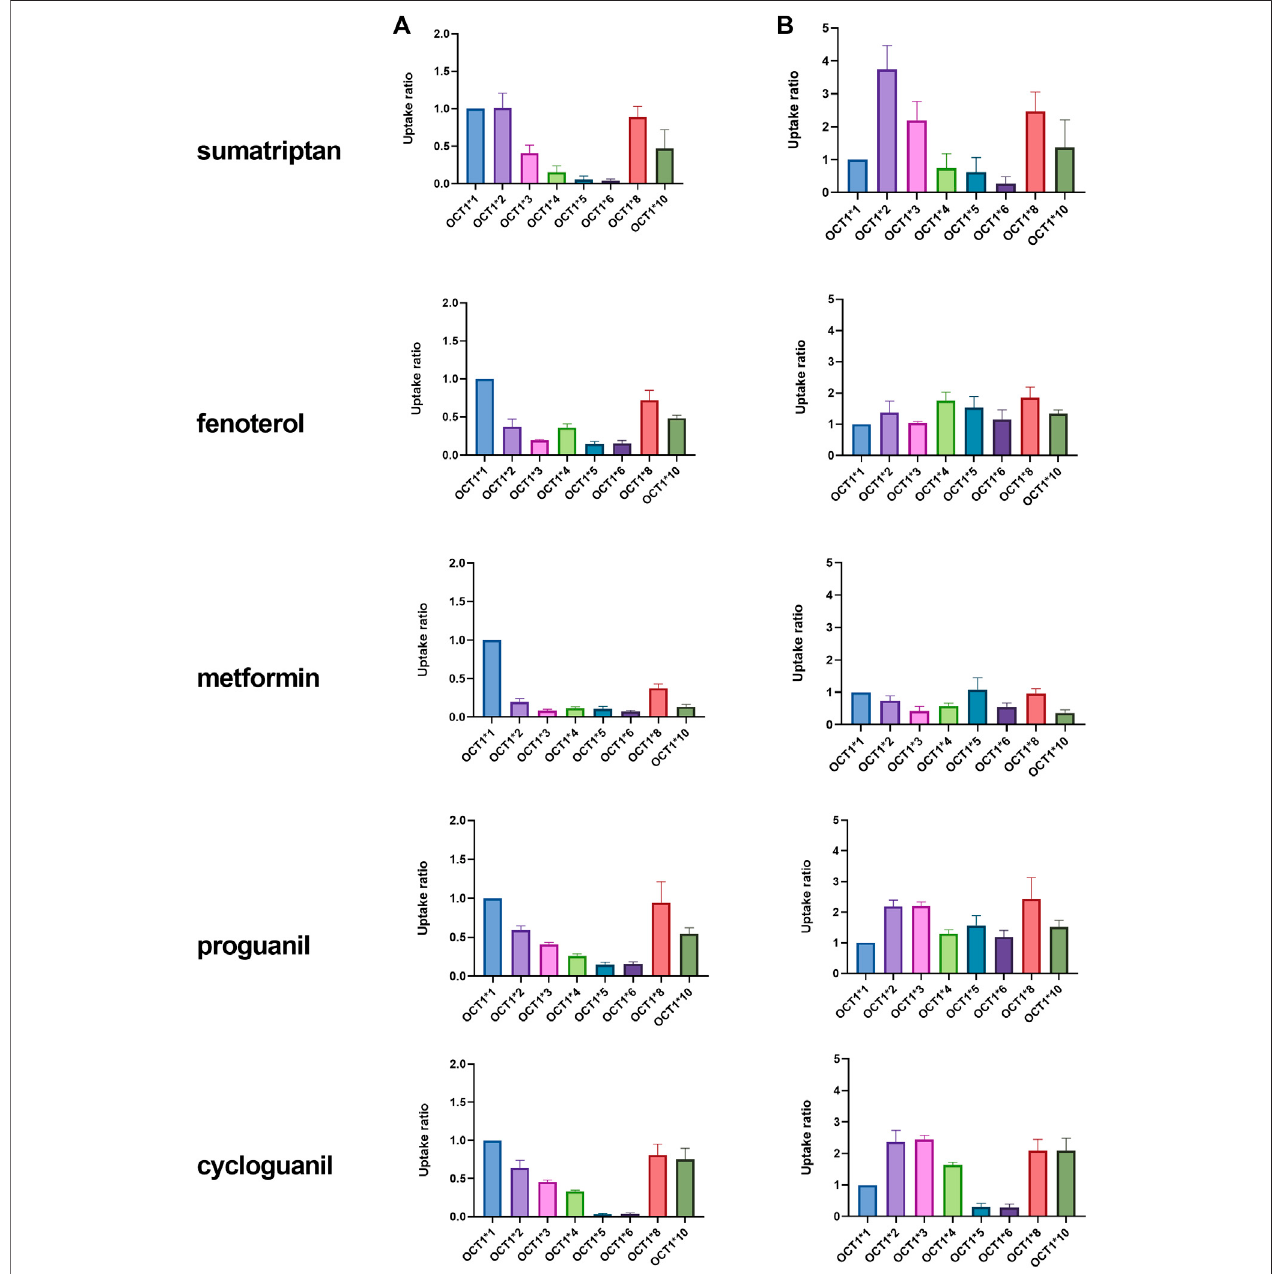
FIGURE1|UptakeofOCT1substratesinHEKcellsexpressingwildtype(*1)andvariantOCT1protein. Uptakewasassessedover1or2 min,depending on substrate, in triplicate, at substrate concentration of 3 μ M, with the exception of metformin, which was assessed at 22 µM. Data are presented as fold uptake compared to OCT1*1 (mean ± SD). Data in column (A) represent uptake prior to normalization for absolute OCT1 membrane protein expression. Data in column (B) represent uptake after normalization for absolute OCT1 membrane protein expression measured in cells expressing each variant.